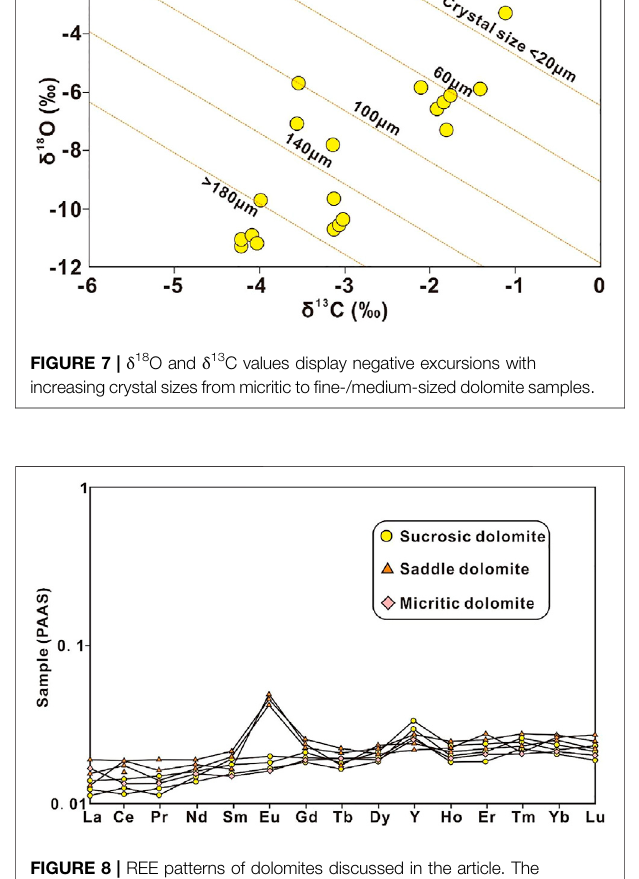
FIGURE 8 | REE patterns of dolomites discussed in the article. The concentrations are normalized to PAAS standard (ref. Nothdurft et al., 2004).